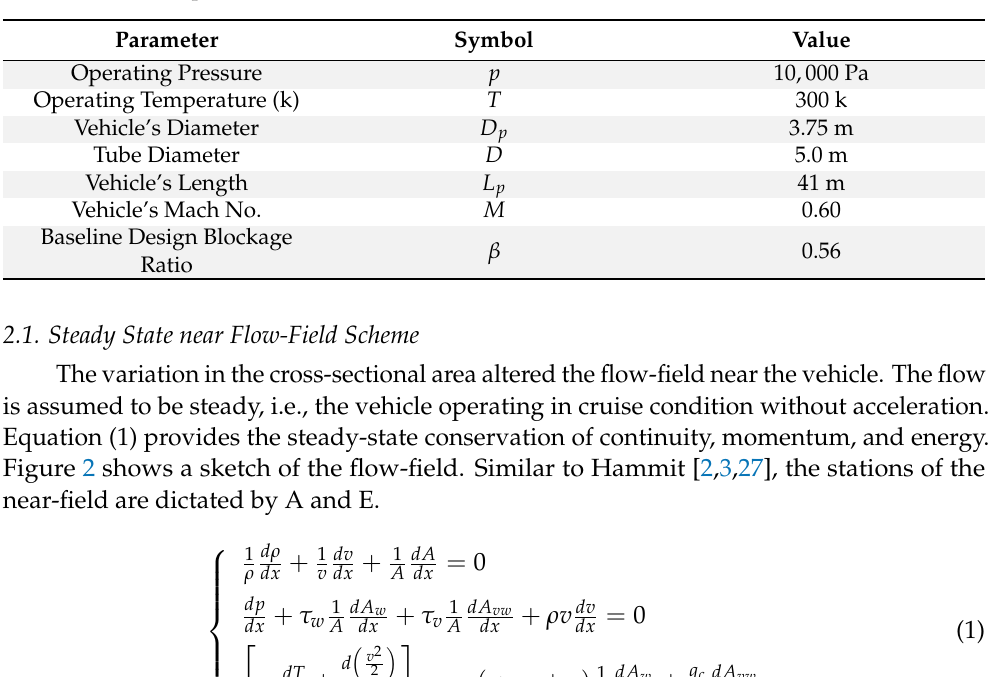
Table 1. Pod tube specifications.